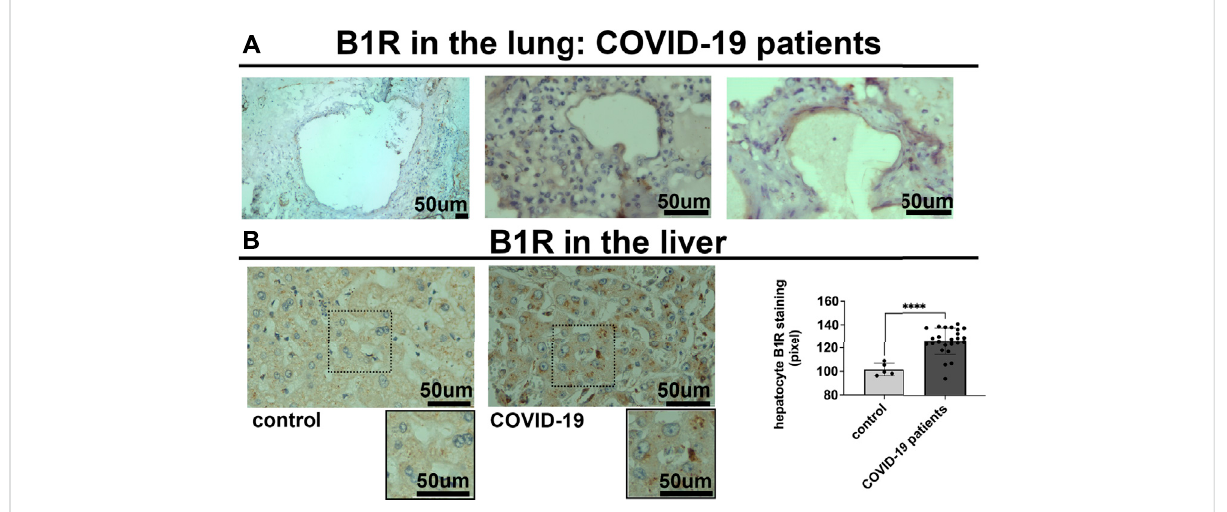
FIGURE 3 Bradykinin 1 receptor (B1R) is expressed in the lung and the liver of SARS-CoV-2 infected patients. (A). Representative images of immunohistochemistry (IHC) staining for B1R in the lung of 3 different COVID-19 patients, as positive control. B1R is observed in alveolar pneumocytes. (B). IHC staining for B1R in the liver of 25 COVID-19 patients (125.9 ± 11.0 a. u.) (on the left) and 5 SARS-CoV-2-uninfected control patients (101.6 ± 5.2 a. u.) (on the right). B1R is observed in hepatocytes. Graphs show quanti fi cation of staining intensity in arbitrary units (a.u.). B1R staining was higher in the liver of COVID-19 patients (**** p < 0.0001). Scale bar = 50